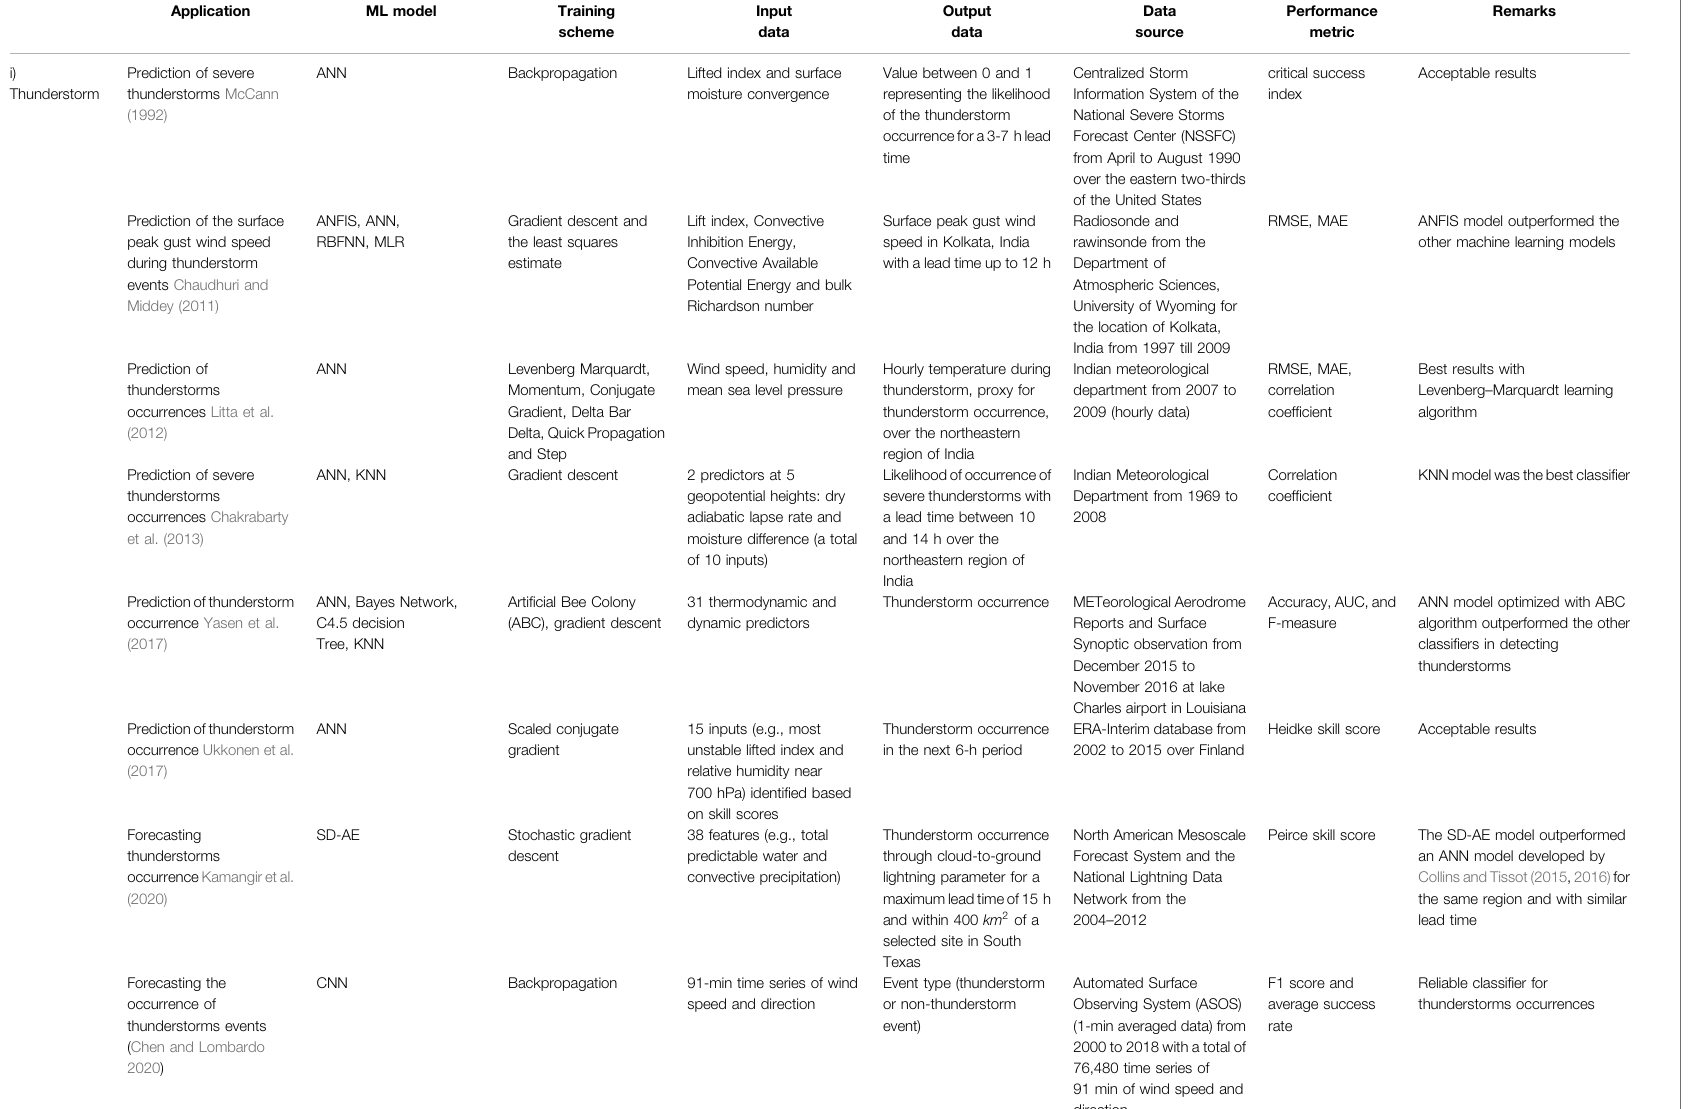
TABLE 3 | Summary of ML applications for non-synoptic